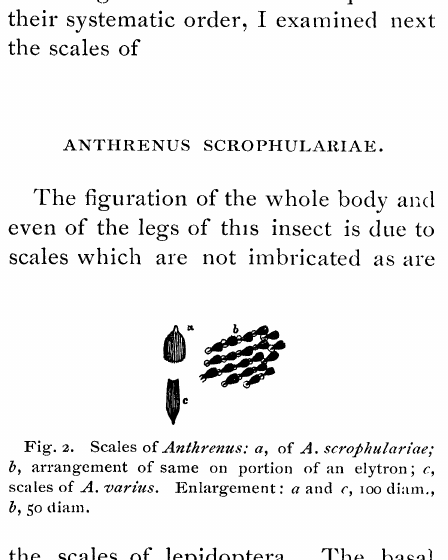
Fig. Scales of Anthrenus: a, of A. scrotbhular/ae; b, arrangement of portion of elytron; c, scales of A. varius. Enlargement: and c, diam., b, 50